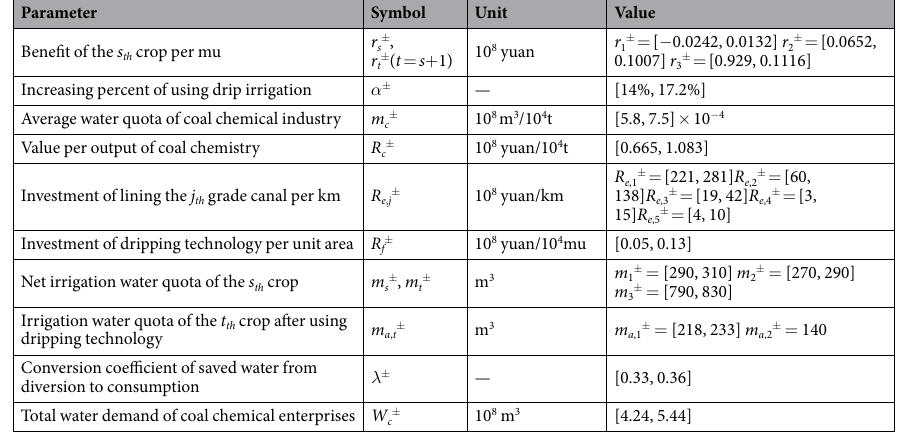
Table 4. The values of interval